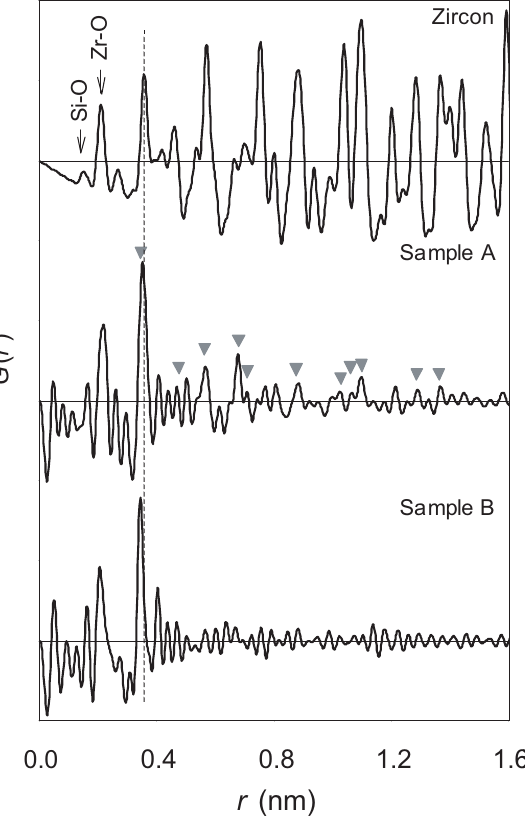
Figure 4. Reduced atomic pair distribution functions G.r/ s of ZrSiO 4 gel sample A and B. Simulated pattern for zir- con is also plotted for comparison. H indicates correlations correspond to cation-cation correlations in crystalline zir-